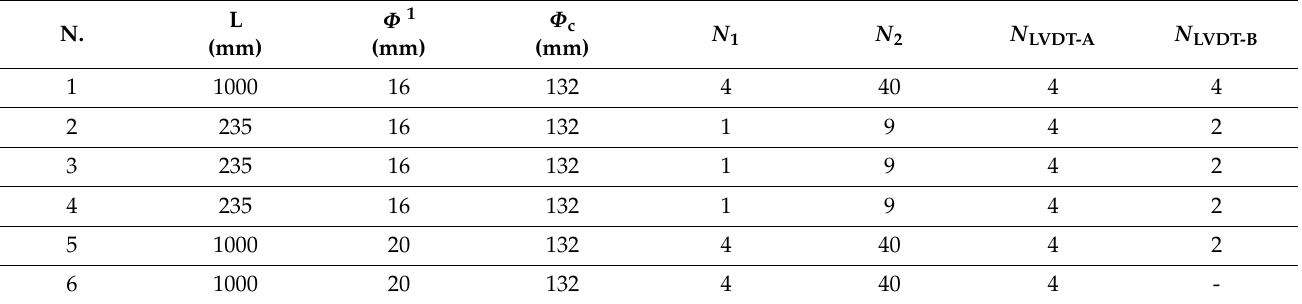
number of electrical strain gauges on the naked bar N 1 and on the embedded bar N 2 , number of